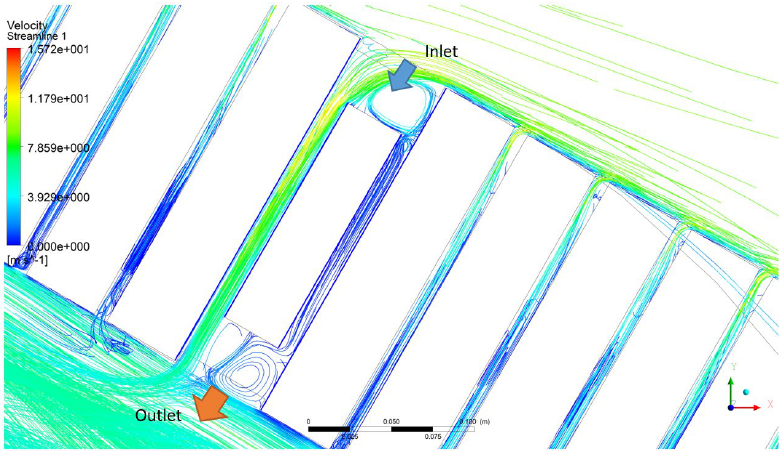
Figure 25. Velocity vectors in the gap in which an accommodation house is located.